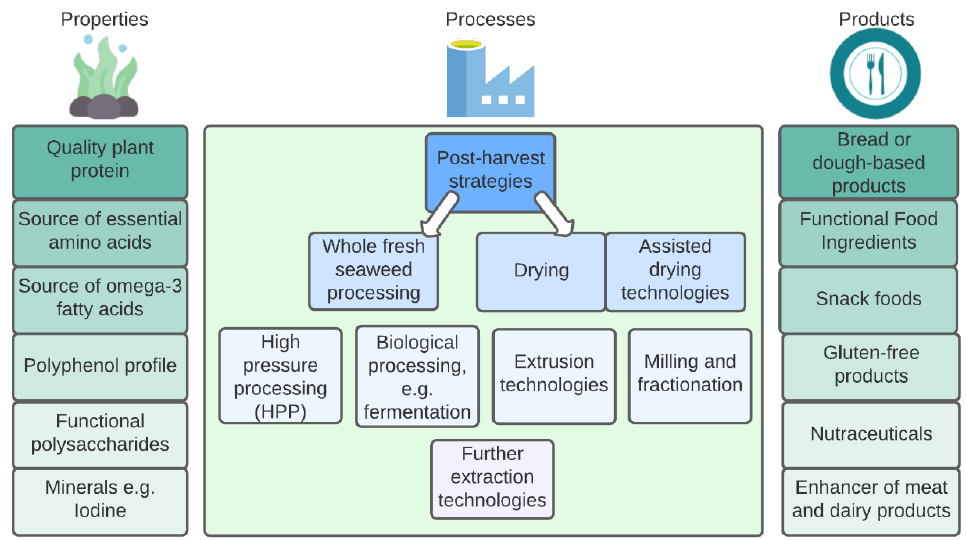
Figure 1. Scheme of seaweed properties, seaweed aquaculture processing and resulting products.